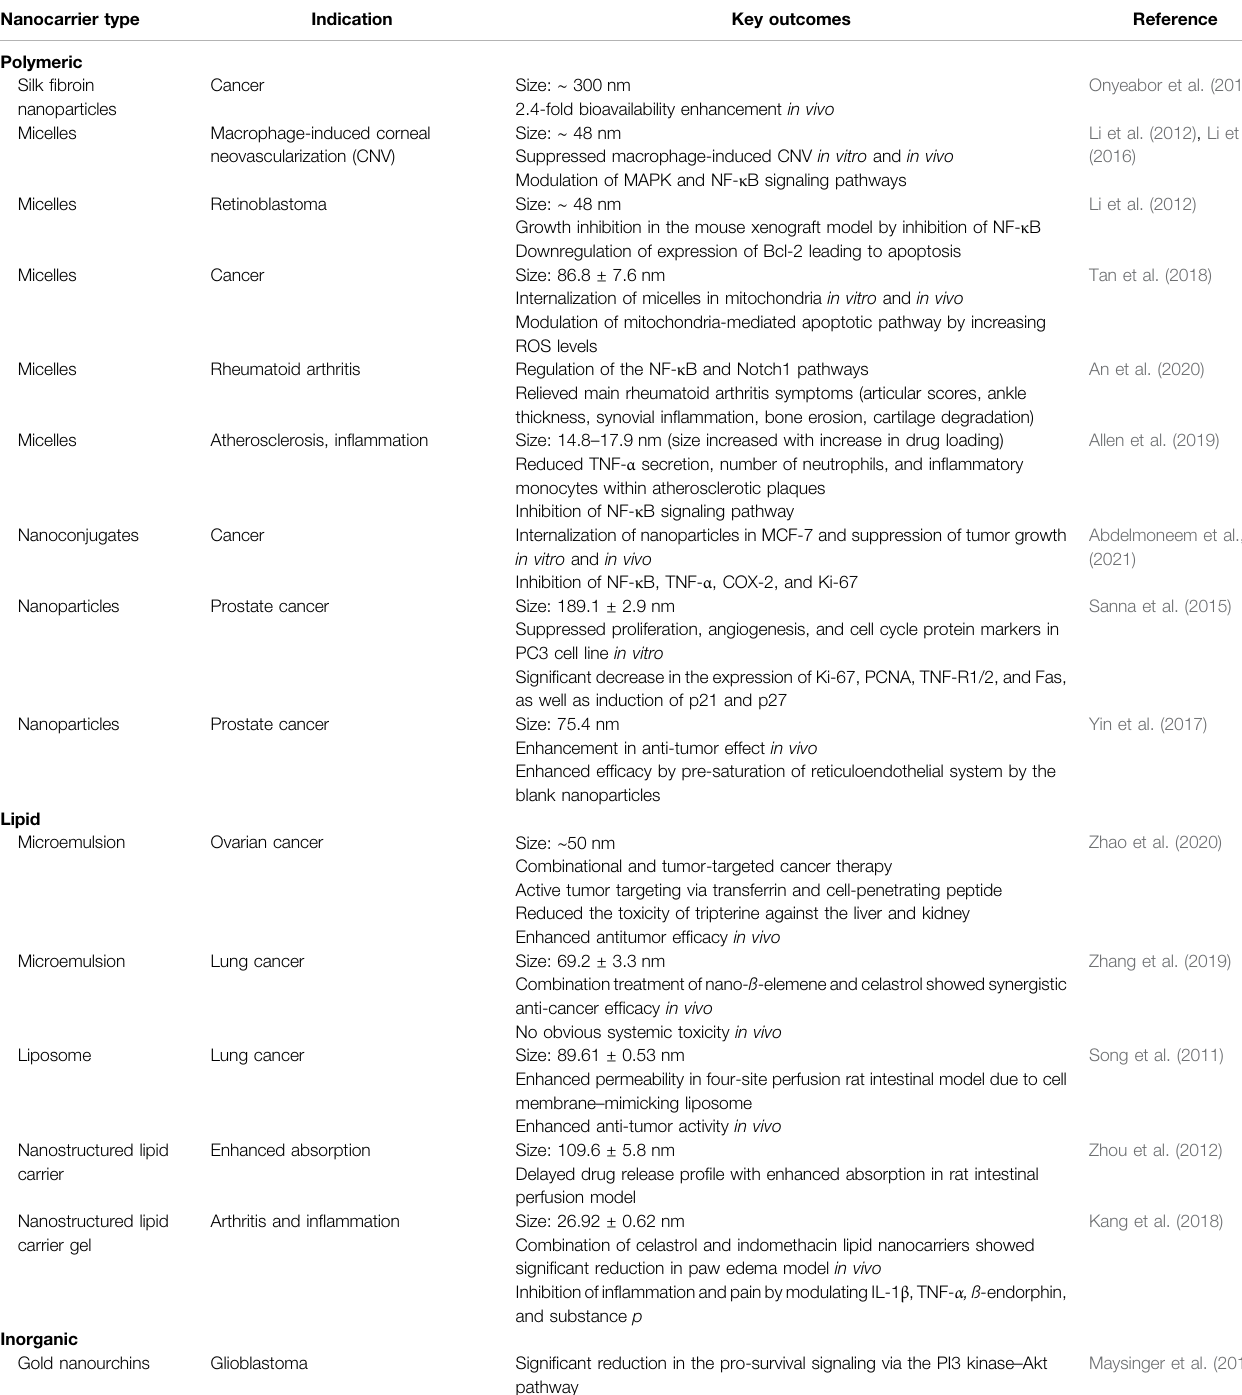
TABLE 1 | Literature overview of nanotechnology-based celastrol formulations. Nanocarrier